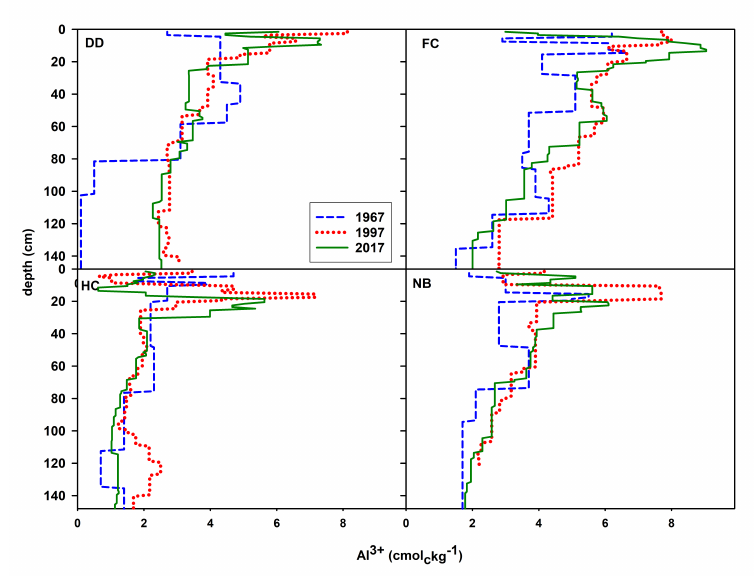
Figure 4. Soil exchangeable Al